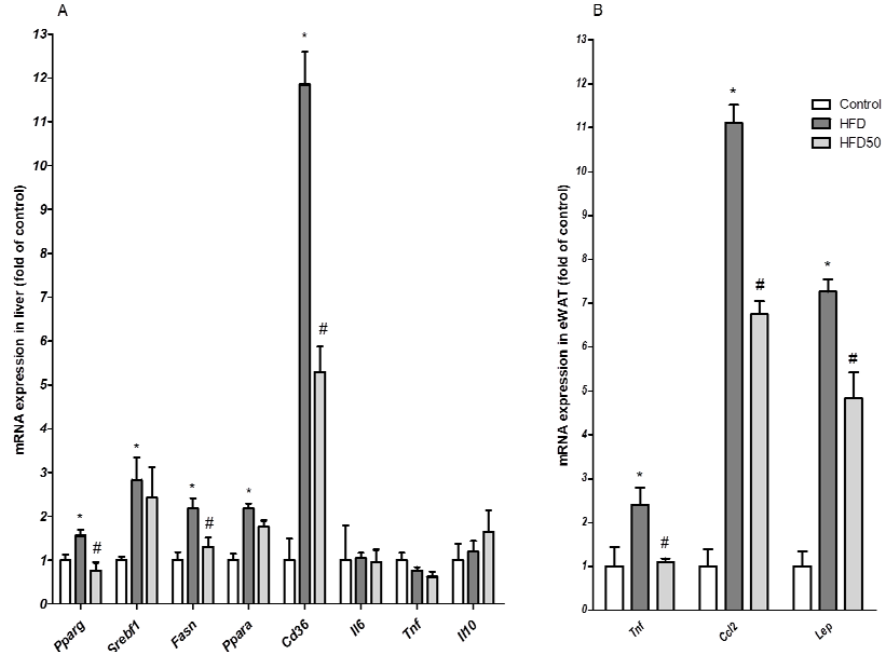
Figure 11. ( A ) mRNA expression in the liver and ( B ) adipose tissue of control mice (Control), obese mice (HFD) and obese mice treated with AERM 50 mg·kg − 1 (HFD50). The results are expressed as the means ± standard errors of the mean ( n = 5). * p < 0.05 when compared with control group and # p < 0.05 compared with the HFD group.